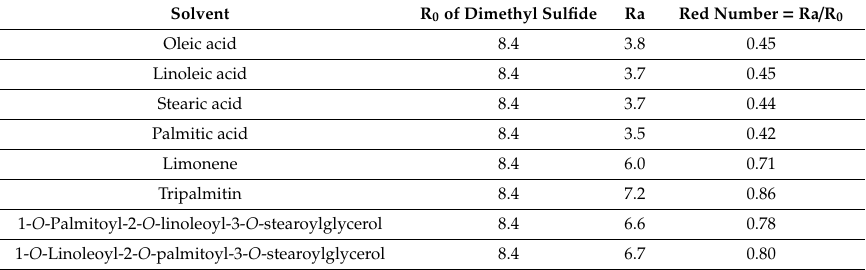
Table 9. Relative energy di ff erence (RED) of dimethyl sulfide for each vegetable